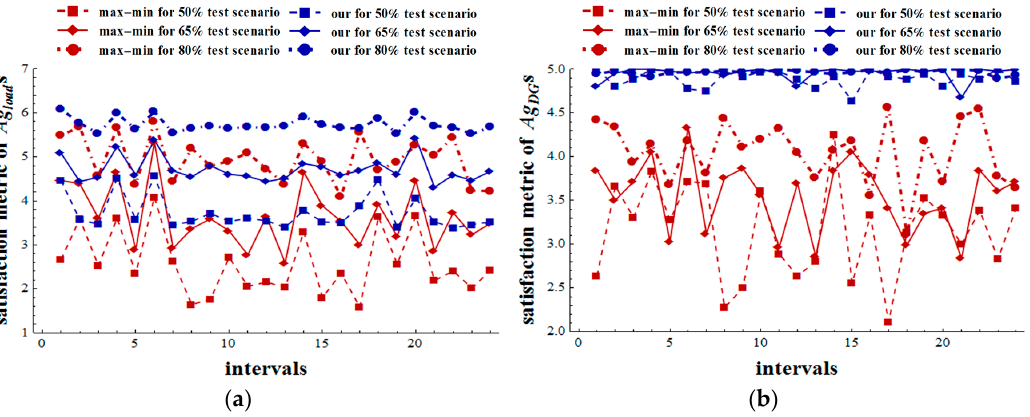
Figure 6. Satisfaction metric ( SM ) for: ( a ) (cid:1839) loads; ( b ) (cid:1840) DGs.